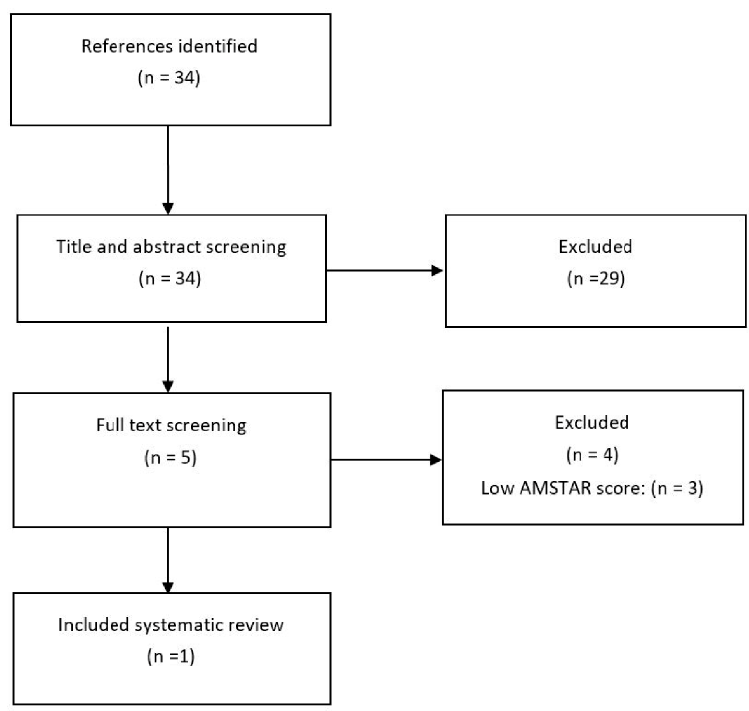
Figure 1. Flowchart of the search for systematic reviews in 2013.